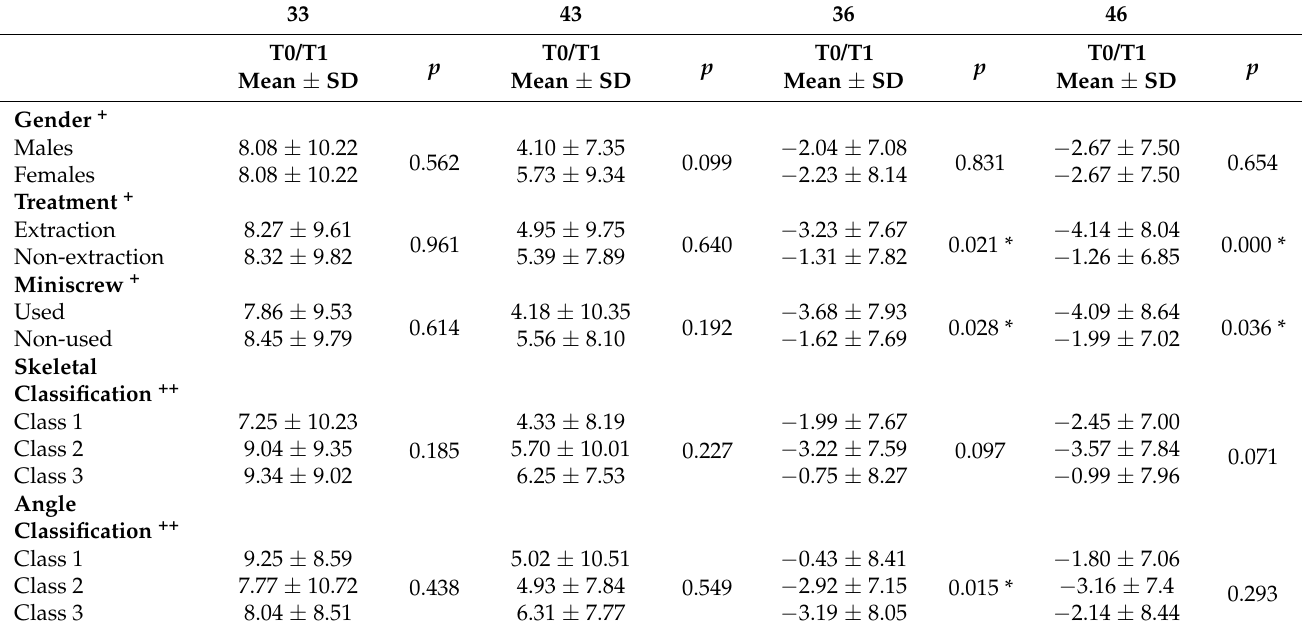
Table 10. Comparison of T0/T1 angulation differences of teeth 33, 43, 36, and 46 between groups for gender, skeletal, and angle